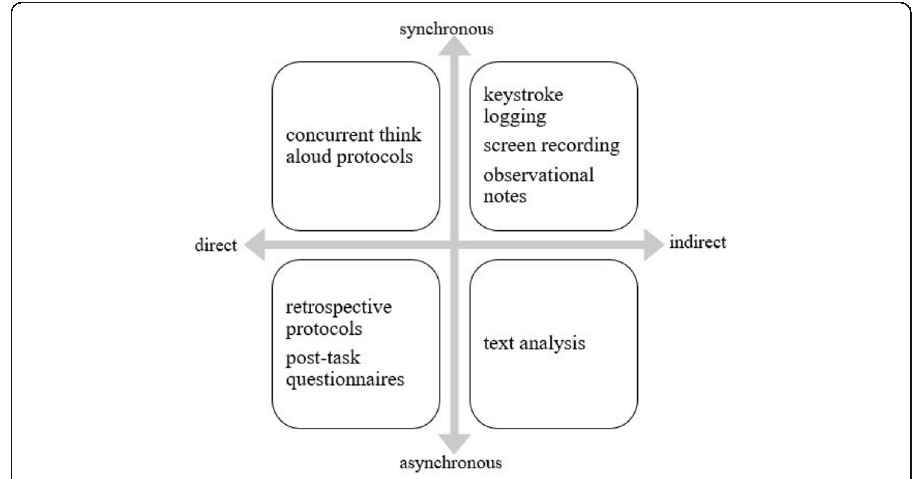
Fig. 1 Classification of methods used in the current study (based on Janssen et al.,